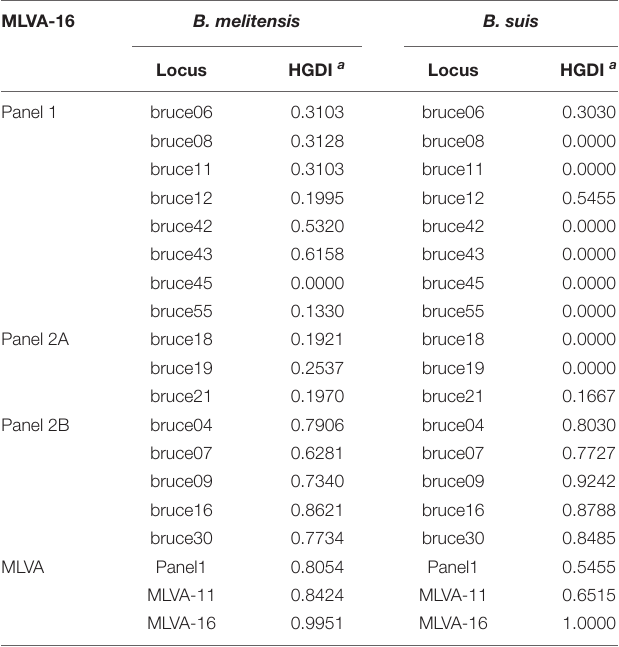
TABLE 2 | HGDI values of 29 B. melitensis isolates and 12 B. suis